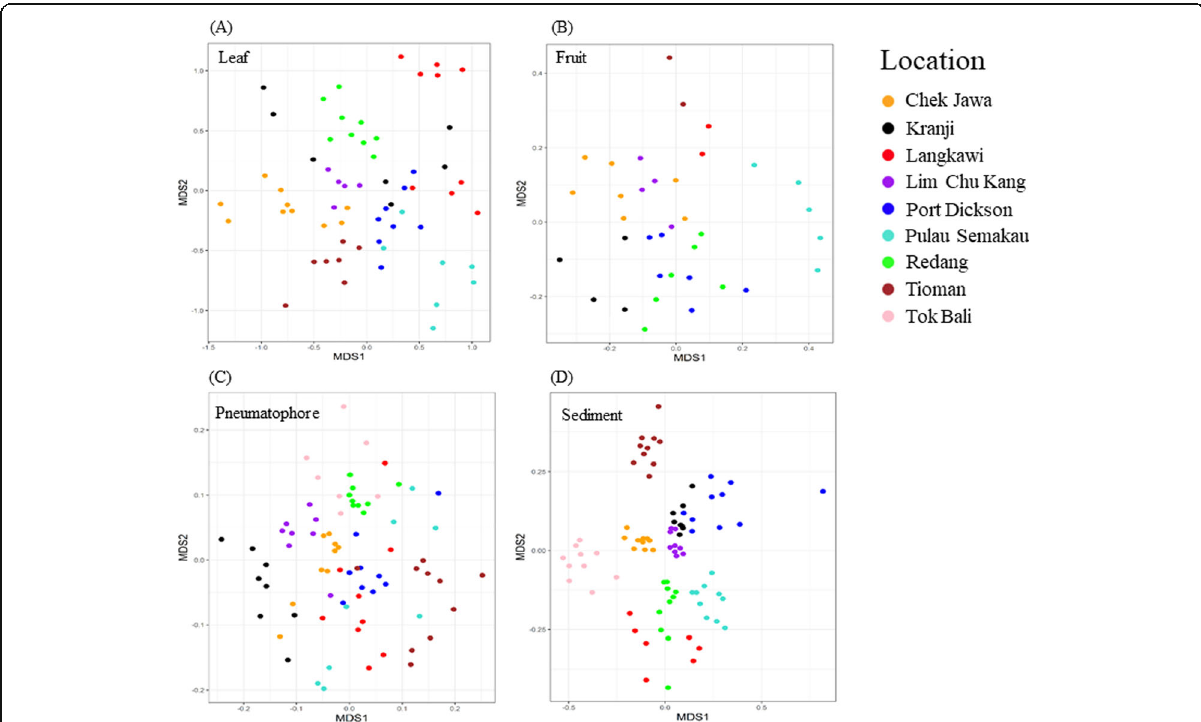
Fig. 2 NMDS plots based on Bray – Curtis dissimilarity for each mangrove part and associated sediment sample, all show clear separation by location. a Leaf, Non-metric fit R 2 = 0.948, linear fit R 2 = 0.743, stress = 0.22 b Fruit, Non-metric fit R 2 = 0.955, linear fit R 2 = 0.775, stress = 0.21 c